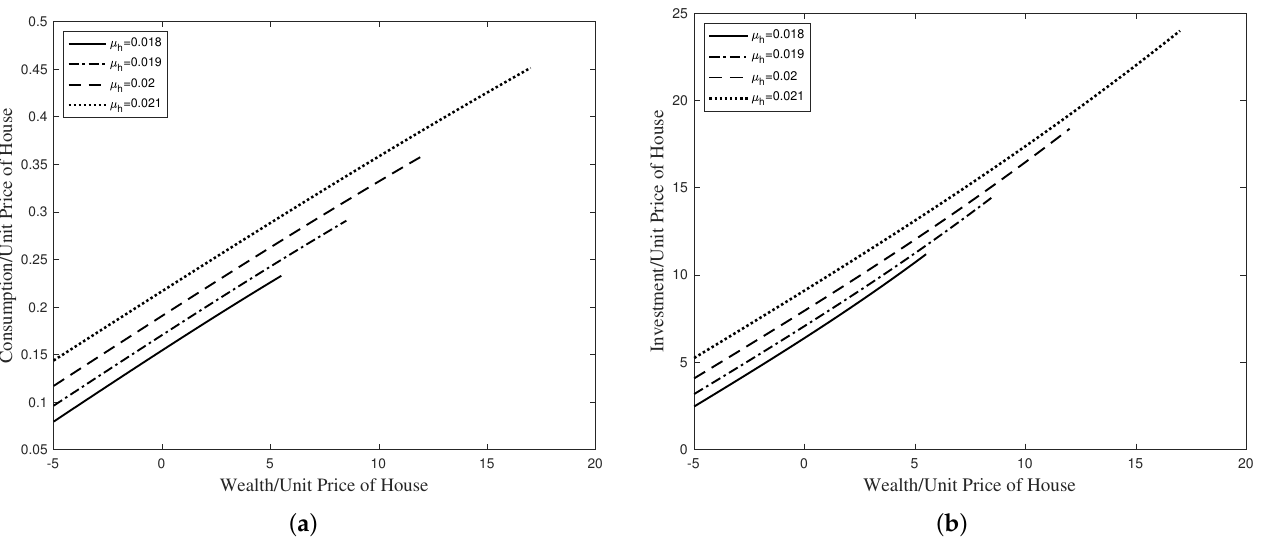
Figure 7. Optimal consumption and investment policies with changes in growth rate of housing price. ( a ) Consumption. ( b ) Investment.